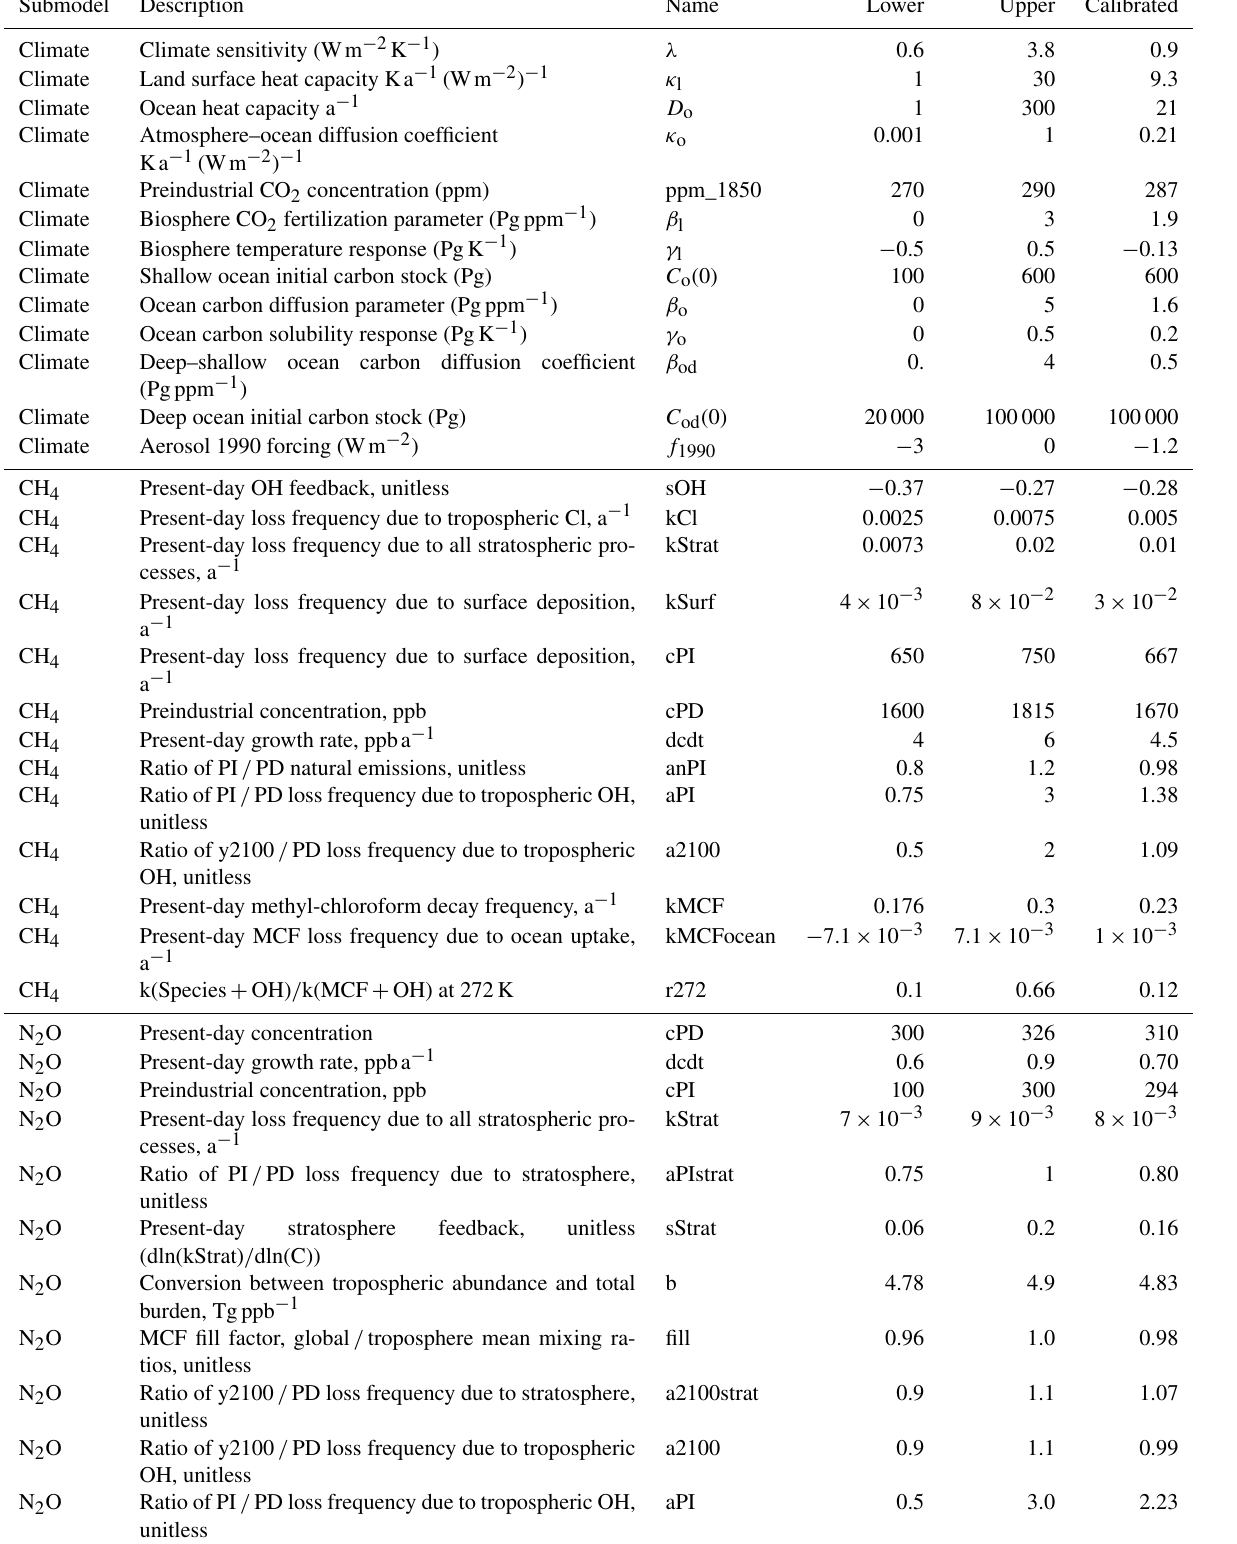
Table B1. Parameter ranges for the MiCES model used in this study, and calibrated parameters for CESM emulation. Submodel